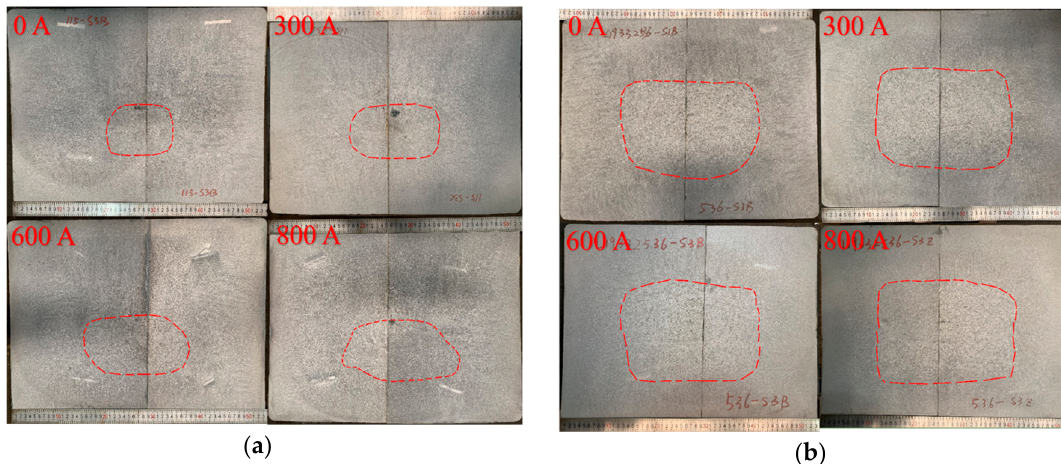
Figure 10. Macroscopic structure of the as-cast bloom cross sections under different combinations of